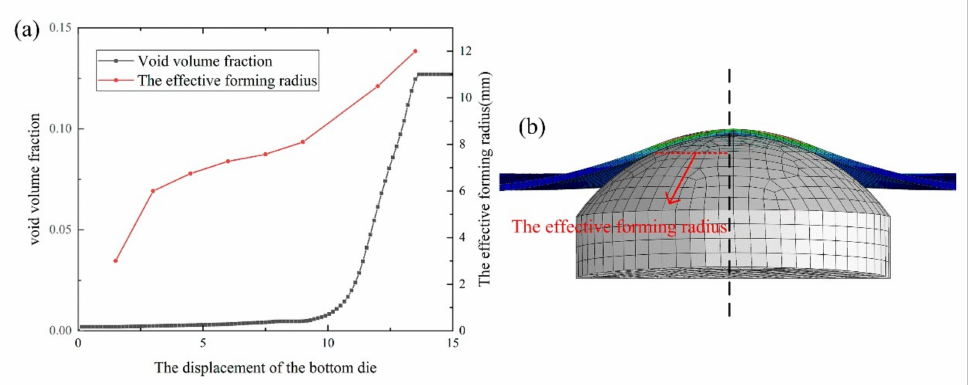
Figure 10. The result of FE simulation of Step1: ( a ) The evolution of void volume fraction; ( b ) The Schematic diagram of the effective forming